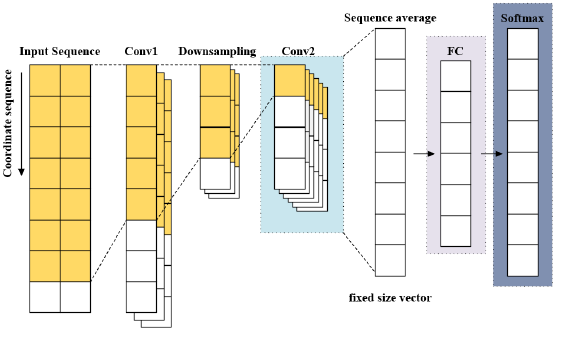
Figure 3. Example of normalization. The character ( left ) before the normalization and that ( right ) after the normalization are given, respectively.